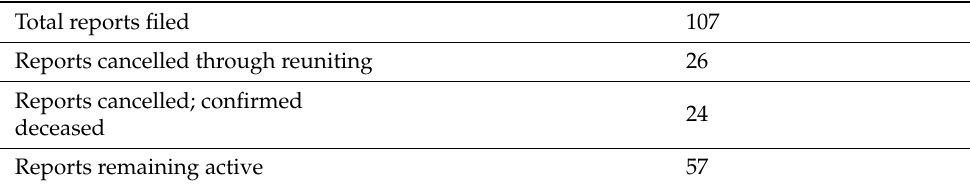
Table 3. Lost Animal Reports Filed at the Humane Society of Boulder